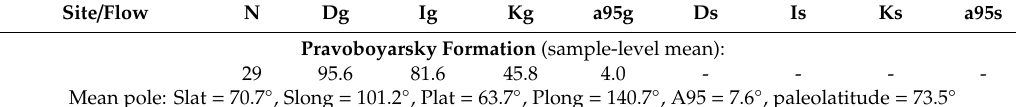
Figure 5. Results of the thermal demagnetization of the Pravoboyarsky and Onkuchaksky formations. ( A – C ) Representative stereoplots, Zijderveld plots and demagnetization paths for the Pravoboyarsky Formation. ( A )—sample PB53, site pb12 . ( B )—sample PB56, site pb13 . ( C )—sample PB41, site pb10 . ( D )—paleomagnetic directions of individual samples for the Pravoboyarsky (geographic coordinate system). ( E – G ) Representative stereoplots, Zijderveld plots and demagnetization paths for the Onkuchaksky Formation. ( E )—sample 45, site on11 . ( F )—sample 36, site on9 . ( G )—sample 32, site on8 . ( H )—site-mean paleomagnetic directions for the Onkuchaksky Formation (stratigraphic coordinate system). Closed (open) circles indicate lower (upper) hemisphere. Table 1. Paleomagnetic directions and poles of Maymecha River